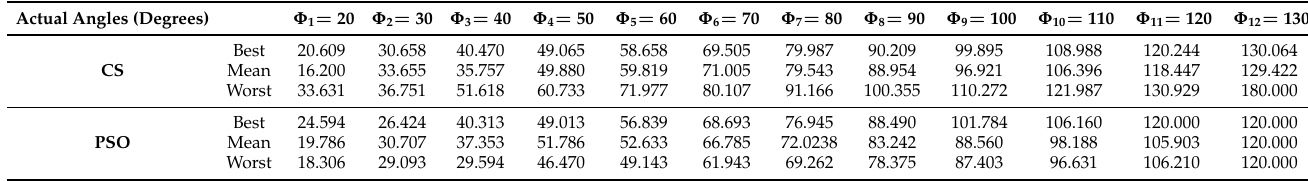
Table 8. Calculation of accuracy for twelve targets at − 5 dB SNR.